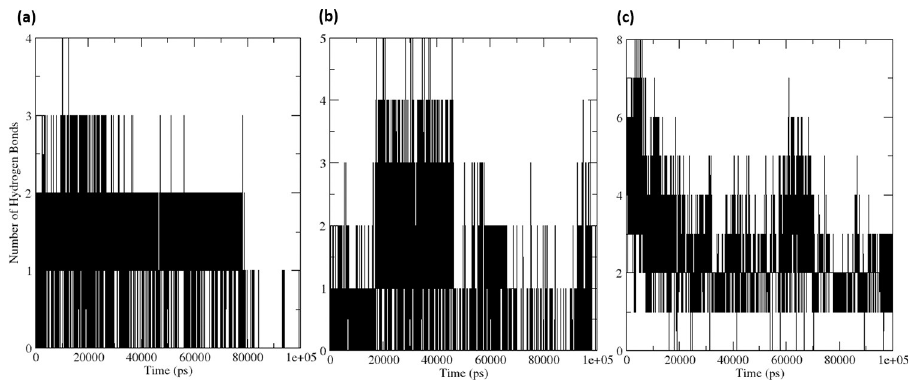
Fig 9. Hydrogen bond counts over the 100 ns MD simulation trajectories for the protein-ligand complexes (a) CMP4 (NET5) (b) CMP2 (NET5) and (c) native inhibitor N3.